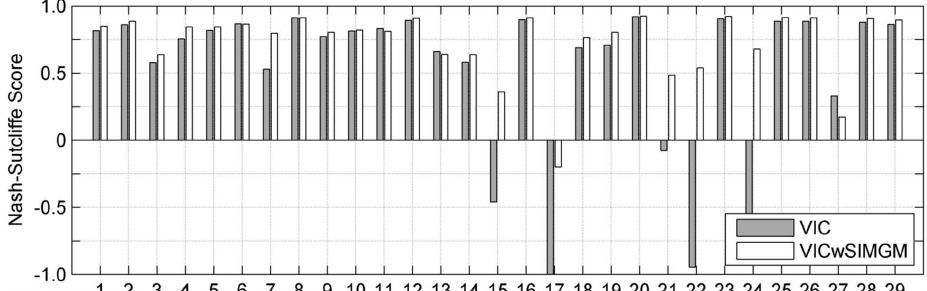
Fig. 4. Nash–Sutcliffe efficiency scores for VIC and VIC-SIMGM in each of the 29 sub-basins.